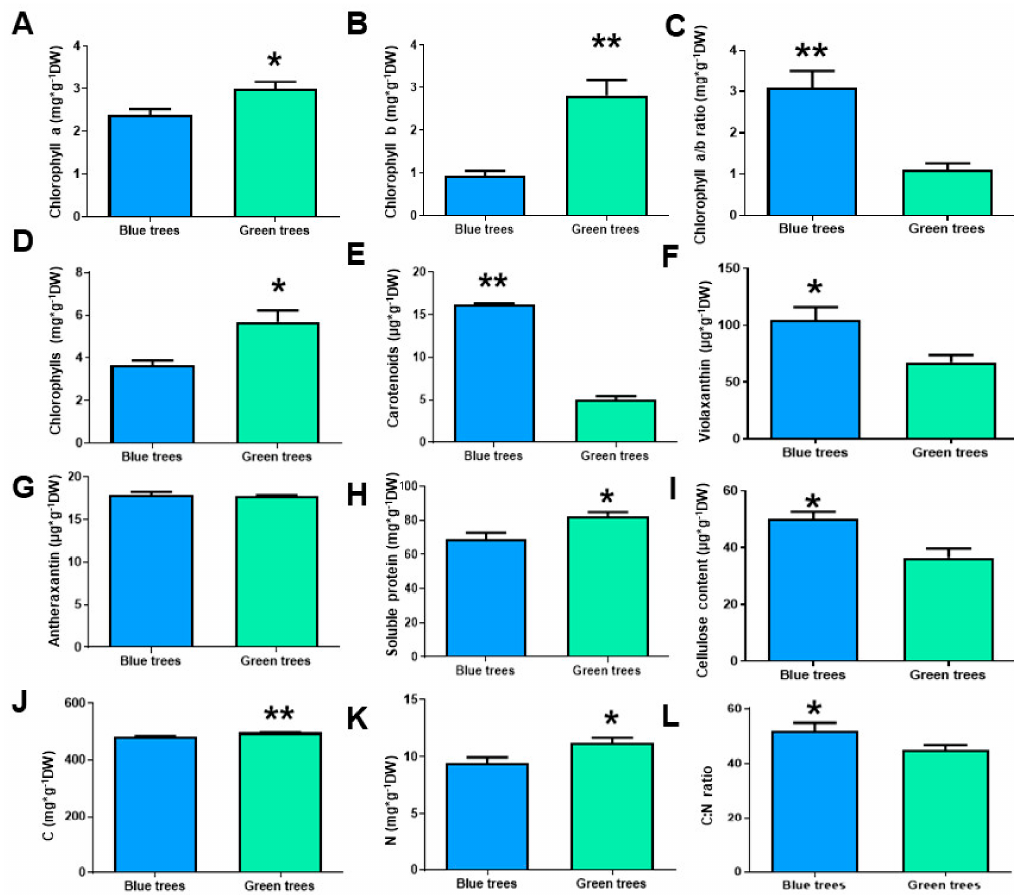
Figure 4. Profiles of plant physiological markers in needles from bluish and green